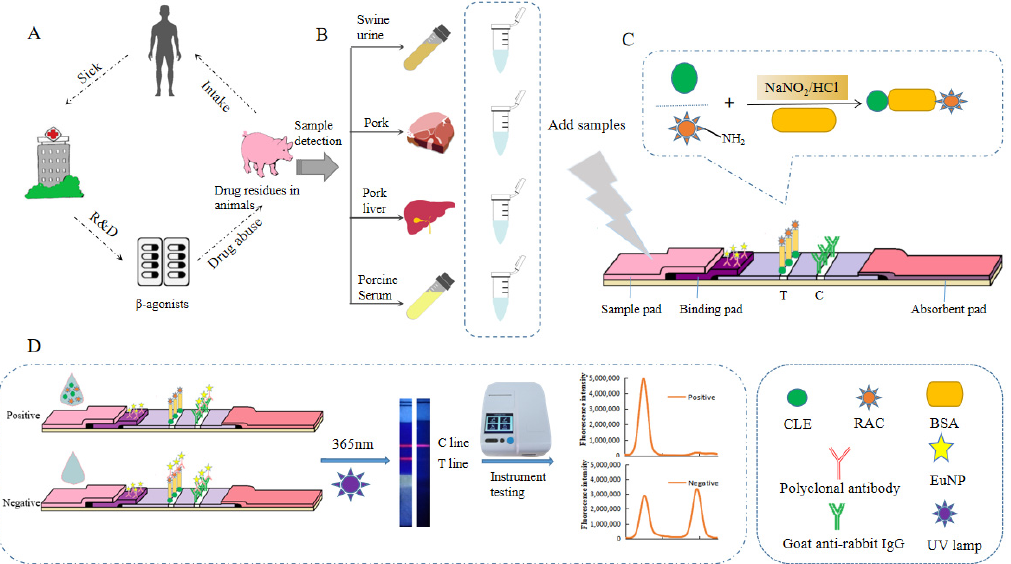
Figure 1. The EuNP-FLFIA detection principle. ( A ) The effects of β 2 -agonist abuse on the human body through the food chain. ( B ) Detection of actual samples. ( C ) Synthesis of dimeric artificial antigen. ( D ) The testing process and test results of the EuNP-FLFIA reader test results.